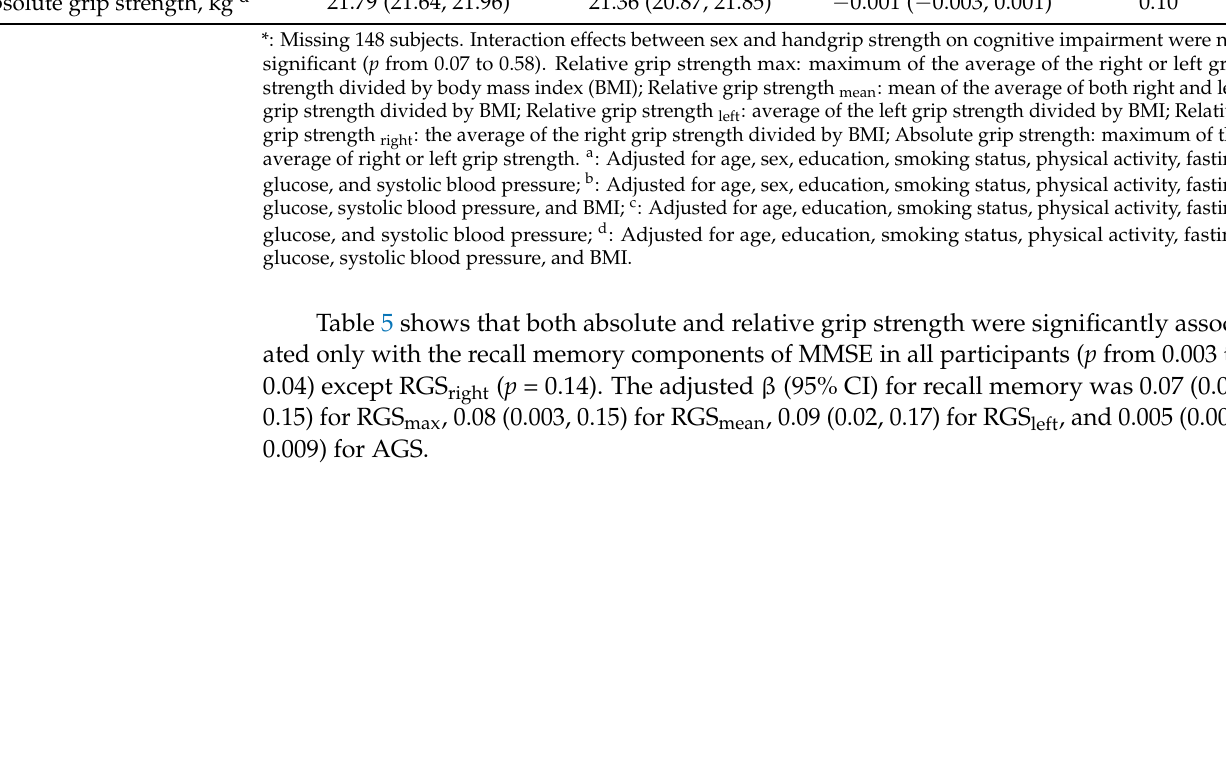
*: Missing 148 subjects. Interaction effects between sex and handgrip strength on cognitive impairment were not significant ( p from 0.07 to 0.58). Relative grip strength max: maximum of the average of the right or left grip strength divided by body mass index (BMI); Relative grip strength mean : mean of the average of both right and left grip strength divided by BMI; Relative grip strength left : average of the left grip strength divided by BMI; Relative grip strength right : the average of the right grip strength divided by BMI; Absolute grip strength: maximum of the average of right or left grip strength. a : Adjusted for age, sex, education, smoking status, physical activity, fasting glucose, and systolic blood pressure; b : Adjusted for age, sex, education, smoking status, physical activity, fasting glucose, systolic blood pressure, and BMI; c : Adjusted for age, education, smoking status, physical activity, fasting glucose, and systolic blood pressure; d : Adjusted for age, education, smoking status, physical activity, fasting glucose, systolic blood pressure, and